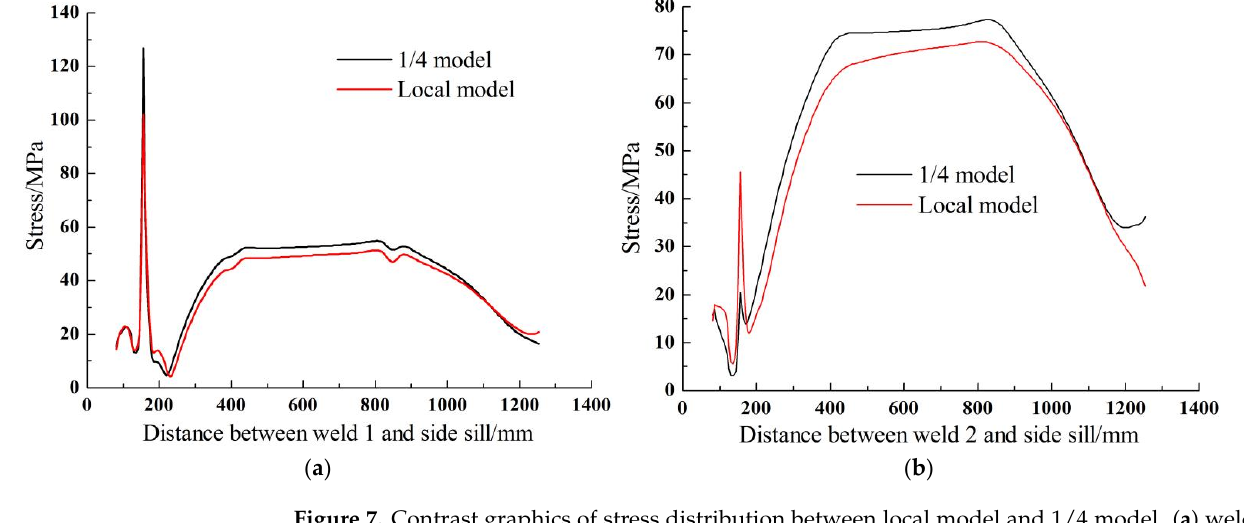
Figure 7. Contrast graphics of stress distribution between local model and 1/4 model. ( a ) weld 1, ( b ) weld 2.